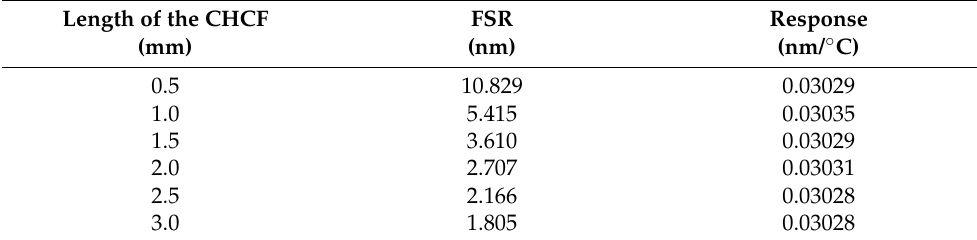
Figure 4. Numerical simulations of the transmission spectra of the MZIs at different temperatures using lengths ( L 0 S ) of 1 mm ( a ), 2 mm ( c ), and 3 mm ( e ). The wavelength shift of one dip of the spectrum as a function of temperature using lengths ( L 0 S ) of 1 mm ( b ), 2 mm ( d ), and 3 mm ( f ). Table 1. Simulation of MZIs using different lengths.